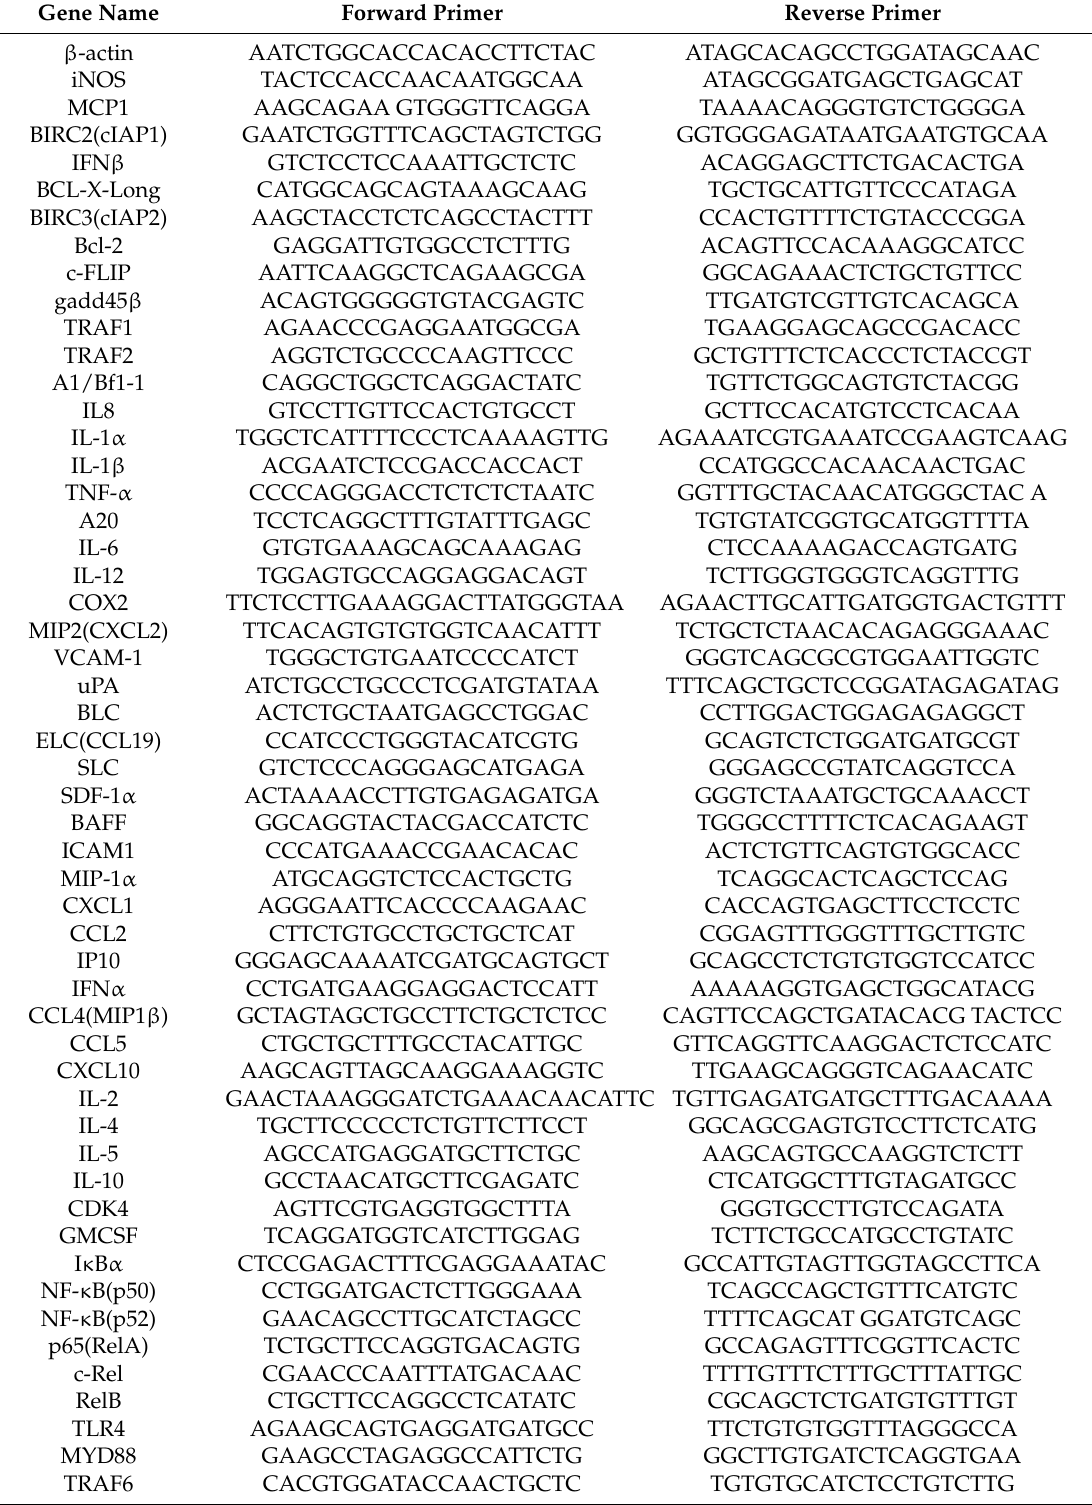
Table 2. Sequences of the primers and probes used in real-time PCR